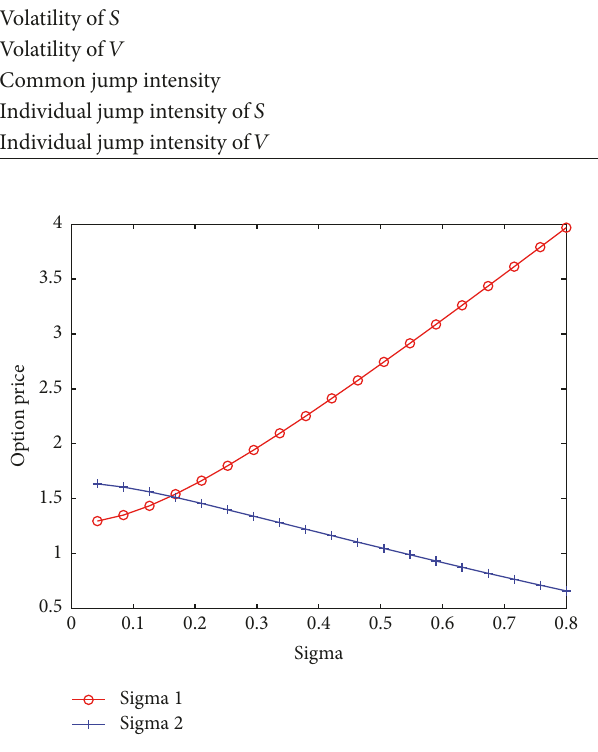
Figure 4: Vulnerable European call option price against standard deviation of the jump sizes of 𝑆 and 𝑉 .